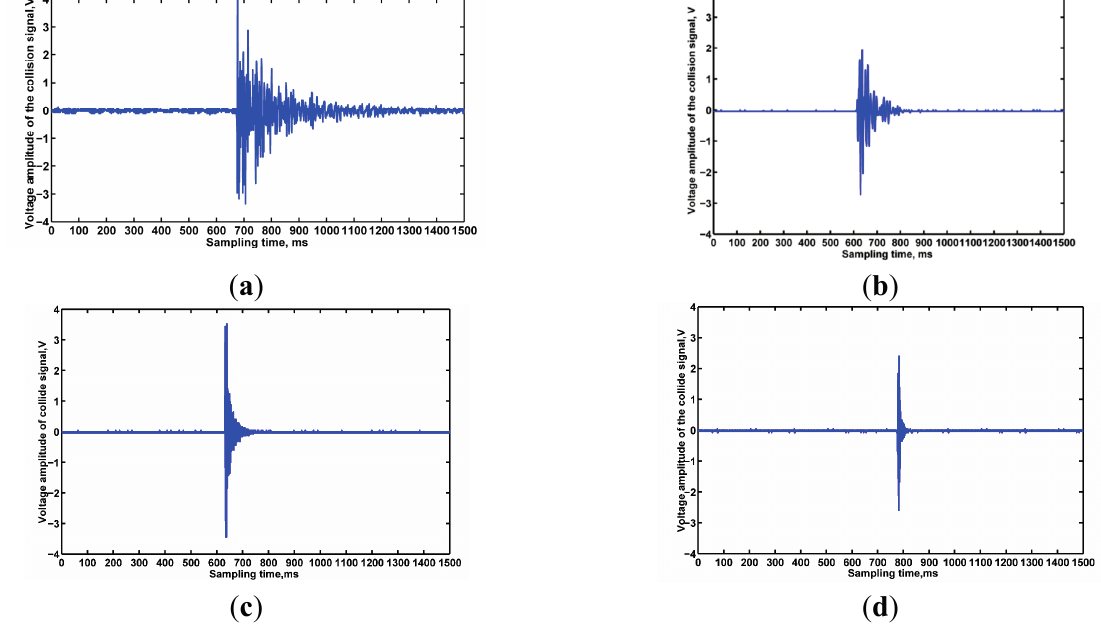
Figure 9. Grain collision signal waveform on different structures. ( a ) h = 0.5, b = 400; ( b ) h = 2.0, b = 400; ( c ) h = 1.0, b = 200; ( d ) h = 2.0, b = 200.